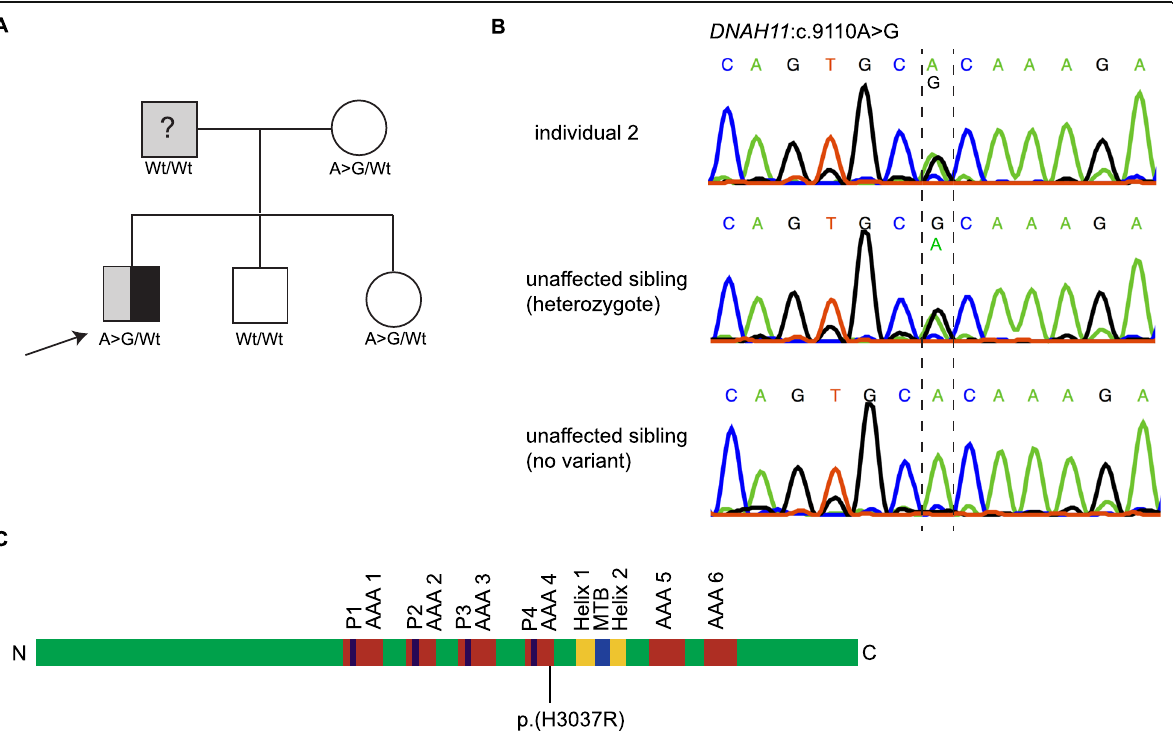
Fig. 3 Genetics individual 2. a Pedigree. Individual 2 (arrow) has situs inversus (black) and DD (gray). The father has self-reported DD, but the dyslexia diagnosis is not confirmed (question mark). Unaffected individuals are shown in white. The genotypes of the variant in DNAH11 are indicated (A > G denotes c.9110A> G, Wt denotes wildtype). b Sanger DNA sequencing chromatogram of individual 2 and controls (2 unaffected siblings). c Schematic representation of the domain structure of DNAH11 and localization of the amino acid substitution p.(H3037R). N =N- terminus, C=C-terminus, P1-P4 = P-loops 1 – 4, MTB = microtubule domain, AAA1 – 6 = AAA modules 1 –